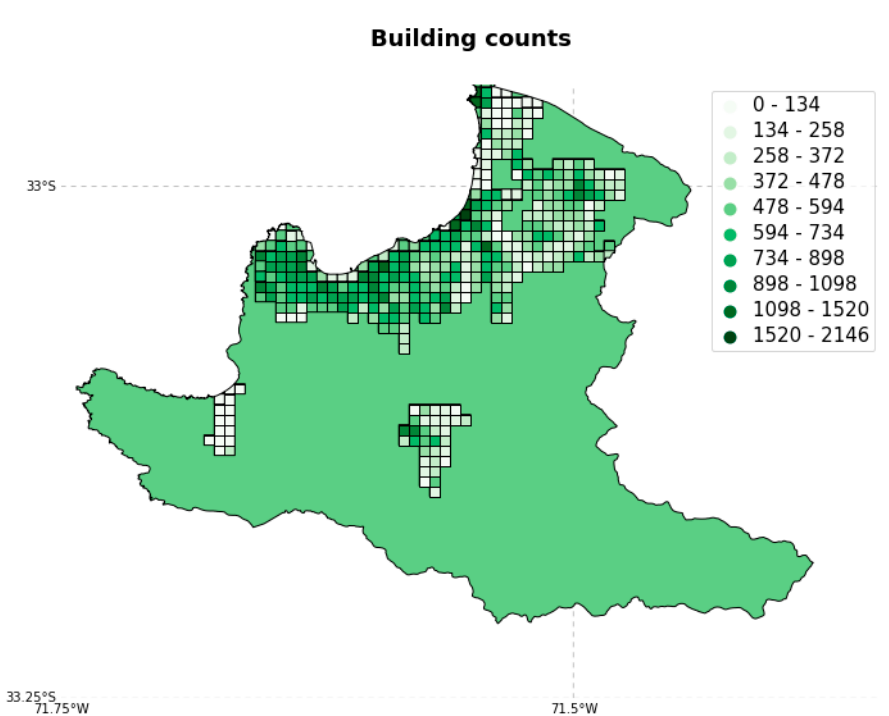
Figure 5. Inferred ranges of residential building counts in the study area. This outcome was obtained from the spatial disaggregation of nighttime residents at the block level as reported by the official 2017 Chilean census.